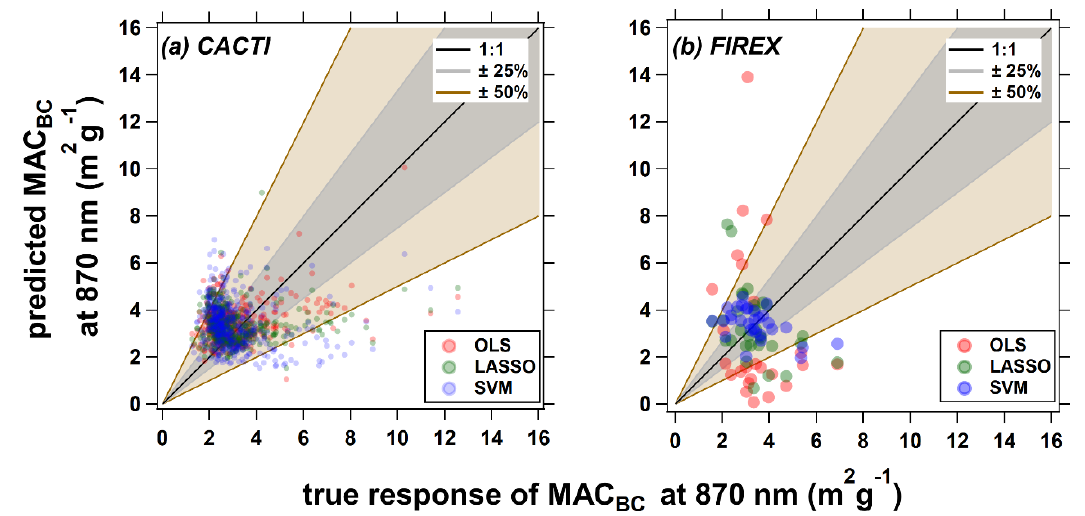
Figure 2. Comparison between the predicted MAC BC and “true” MAC BC using independent validation CACTI ( a ) and FIREX ( b ) datasets. Only three representative techniques (OLS, LASSO, and SVM) are included in the figure. The results of the other techniques can be found in Figure S9. The grey and brown shaded regions represent predicted errors < ± 25% and < ± 50% referenced to the line of perfect agreement (1:1).